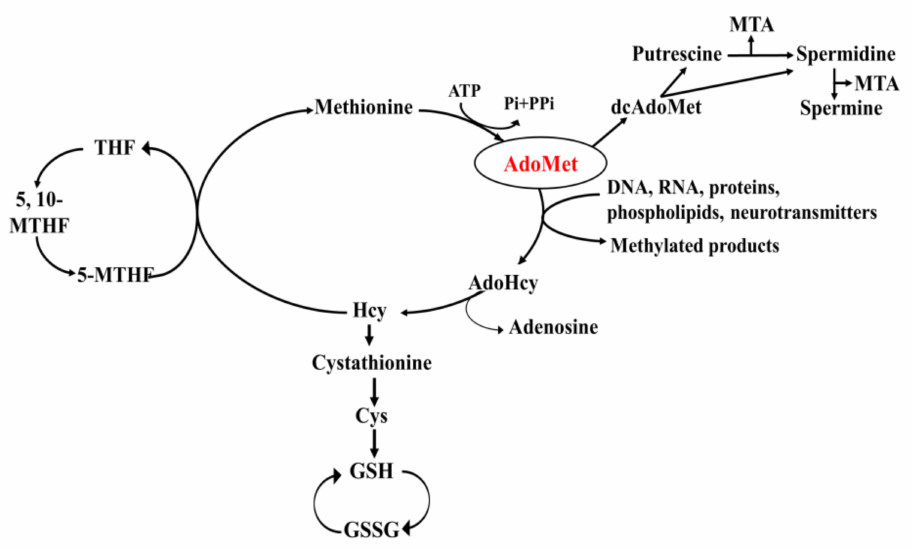
Figure 2. Metabolic relationships among transmethylation, trans-sulfuration, folate cycle, and polyamine synthesis. AdoHcy: S-adenosylhomocysteine; dcAdoMet: S-adenosyl-(5’)-3-methylthiopropylamine; Cys: cysteine; GSH: reduced glutathione; GSSG: oxidized gluthatione: Hcy: